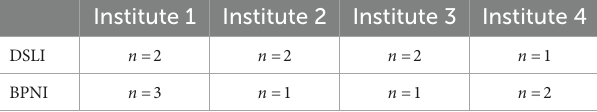
TABLE 4 Number of participants in the dimensions of social learning interview and the basic psychological needs interview per